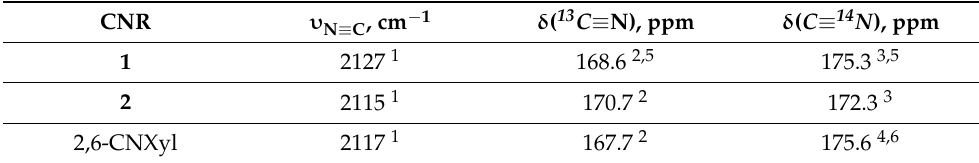
Table 1. Selected FTIR, 13 C NMR, and 14 N NMR data for 1 , 2 , and 2,6-CNXyl.